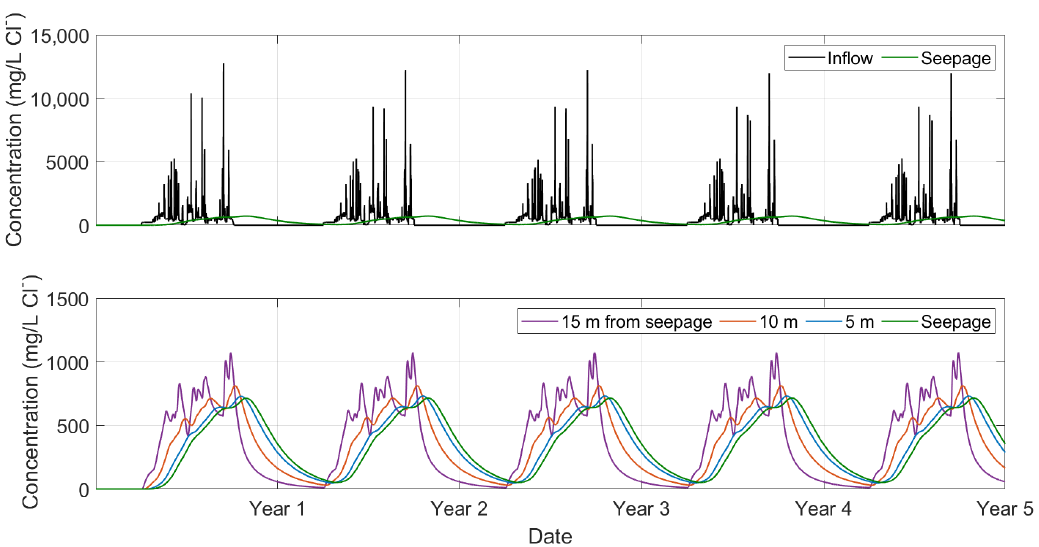
Figure 10. Concentration–time plots of output from the numerical model over five years of simulation time. The top panel shows the differences in salinity between the inflow to the wetland (black line) and the seepage face (dark green). The bottom panel shows the output from the simulated monitoring wells. Salinities decrease with distance travelled through the wetland, with the lowest salinities occurring at the seepage face.